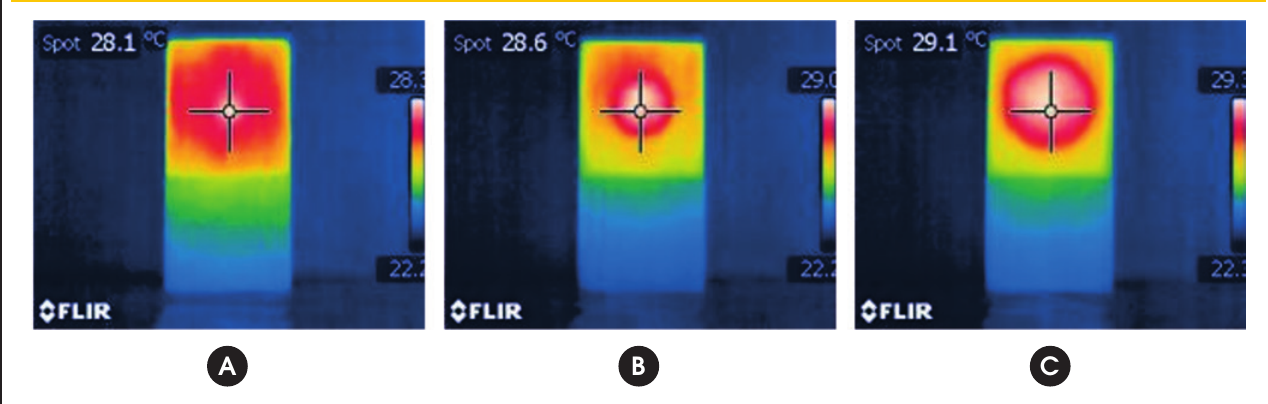
Figure 35 – Infrared images indicating the temperature in the point of the artificial defect